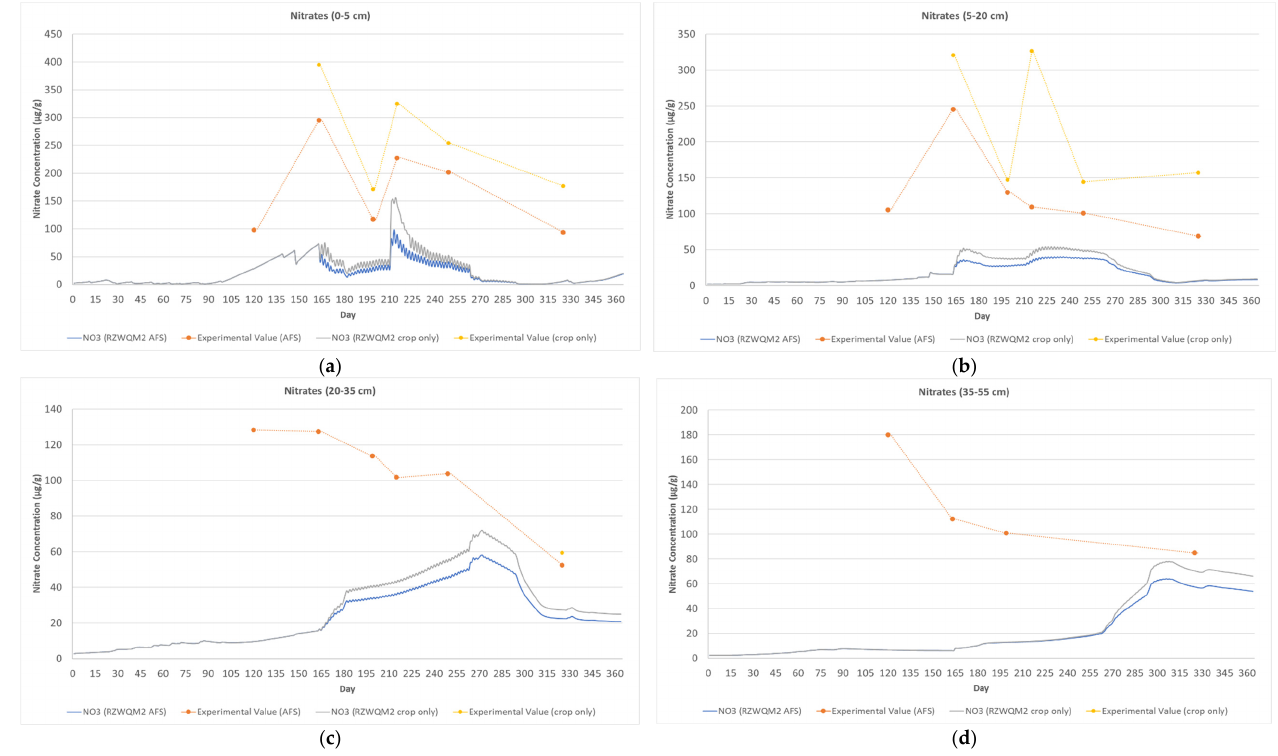
Figure 2. Comparison of nitrate concentrations in the soil profile of the AFS and maize-only system for various sampling depths: ( a ) 0–5 cm, ( b ) 5–20 cm, ( c ) 20–35 cm, and ( d ) 35–55 cm (where no points are presented, sampling was not possible due to soil compaction. Fertilization was carried out on days 163 and 210).